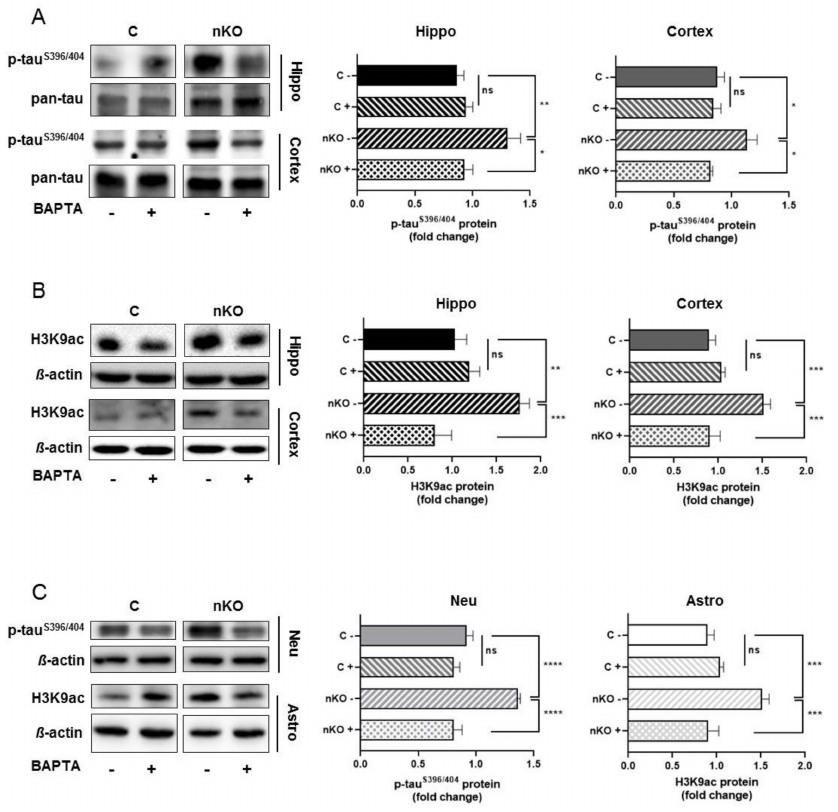
Figure 3. BAPTA-AM treatment reversed tau S396 / 404 hyperphosphorylation and H3K9 acetylation in the brain of SGPL1 fl / fl / Nes mice.( A ) Protein quantification of phospho-tau S396 / 404 and total tau (pan-tau) in the hippocampus (Hippo, black) and cortex (dark grey) of control ( C ) and SGPL1 fl / fl / Nes (nKO) mice with ( + ) and without (-) BAPTA-AM treatment. ( B ) Protein quantification of H3K9 acetylation (H3K9ac) and total H3 in the hippocampus (Hippo, black) and cortex (dark grey) of control ( C ) and SGPL1 fl / fl / Nes (nKO) mice with ( + ) and without (-) BAPTA-AM treatment. ( C ) Protein quantification of phospho-tau S396 / 404 and H3K9 acetylation (H3K9ac) in neurons (Neu, light grey) and astrocytes (Astro, white) in control ( C ) and SGPL1 fl / fl / Nes (nKO) mice with ( + ) and without (-) BAPTA-AM treatment. For all: Bars mean +/ − S.E.M, One-Way ANOVA with Tukey’s post-hoc correction, n = 3 − 7, * p < 0.05, ** p < 0.01, *** p < 0.001, **** p < 0.0001, ns = not